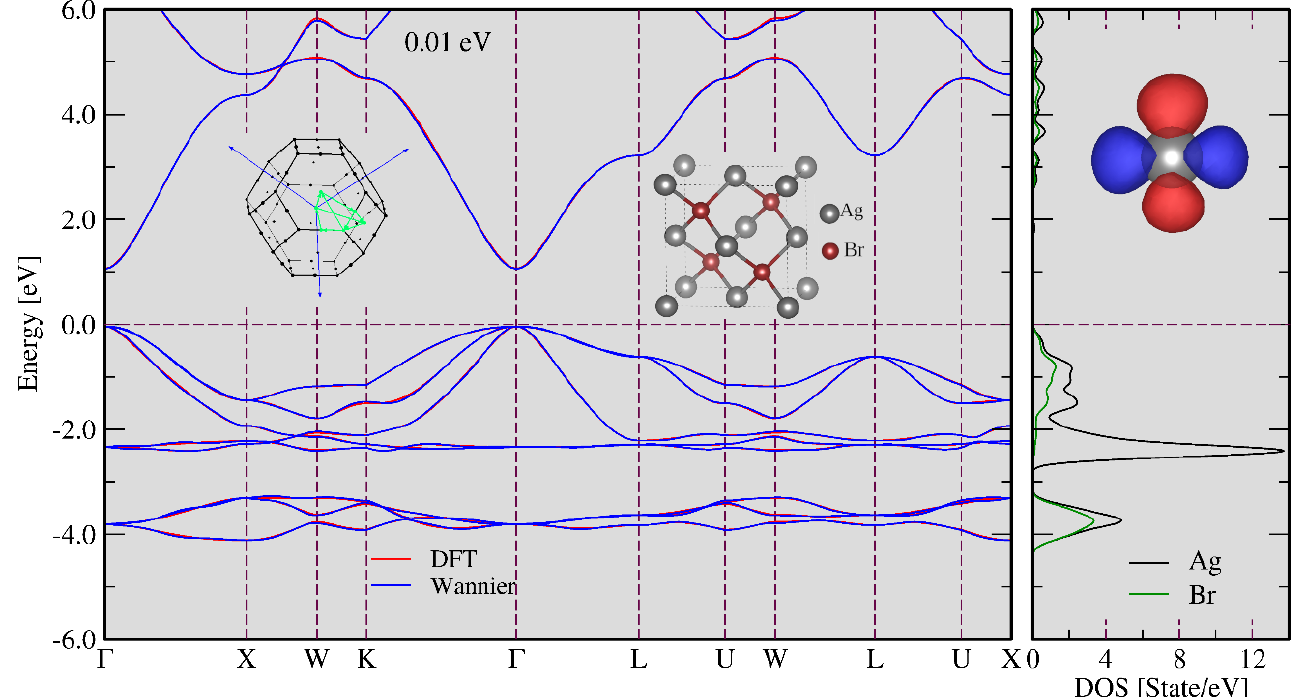
Figure 1. Electronic band structure for the AgBr unit cell, where the Ag and Br atoms are shown in silver and brown balls and the Brillouin zone ( left panel). Summed electronic density of states (DOS) for AgBr and d-Ag Wannier orbitals ( right panel).